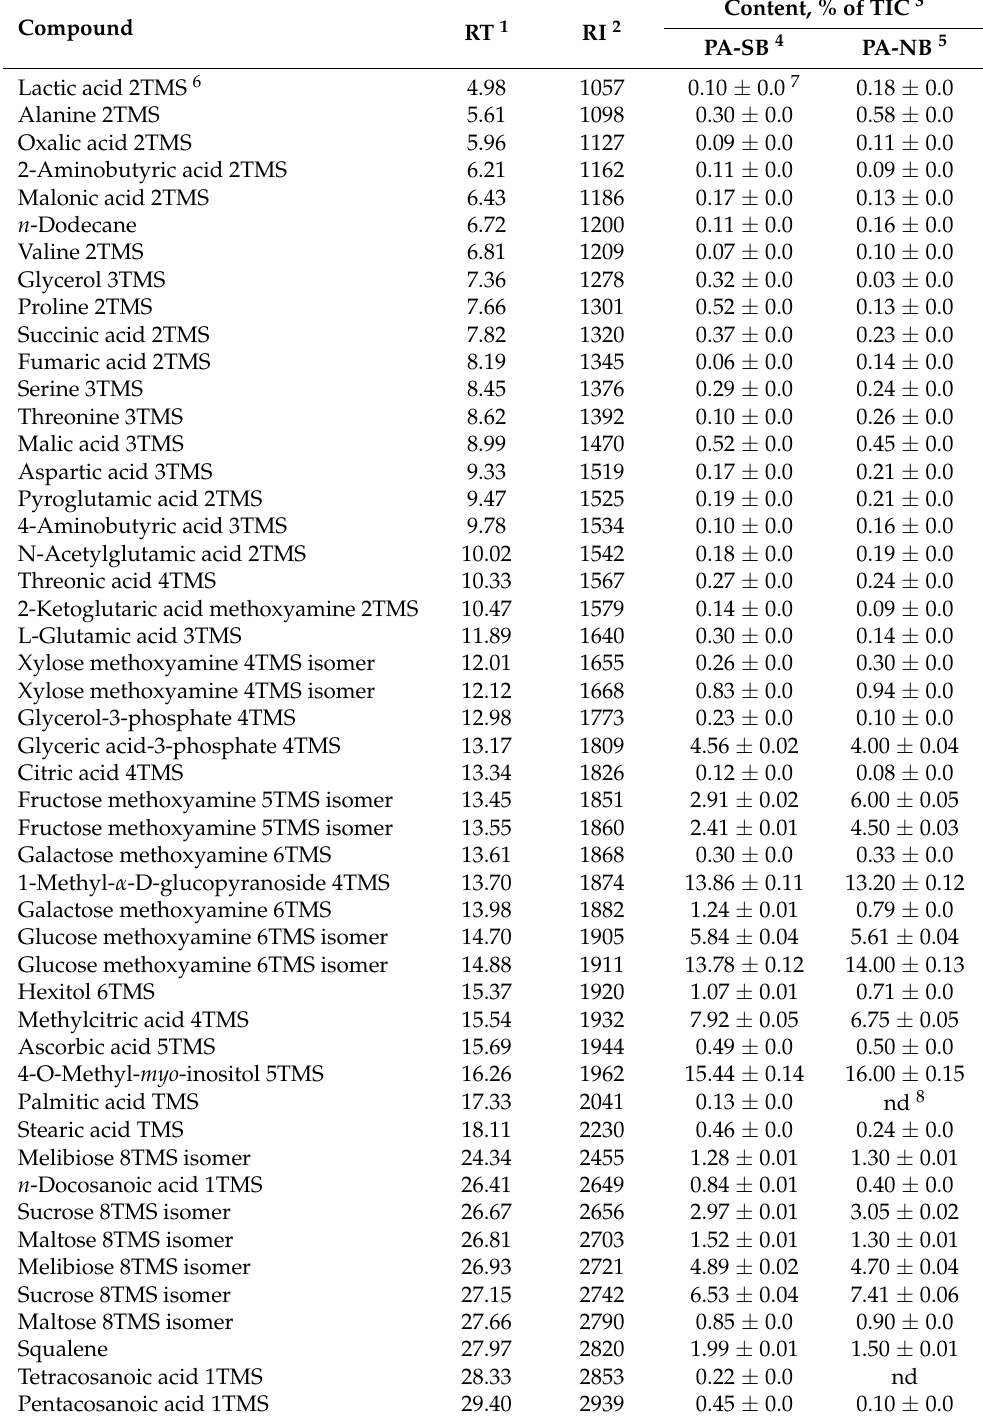
Table 8. Identification of the chemical composition (GC-MS) of dry ethanolic extract from Physalis alkekengi